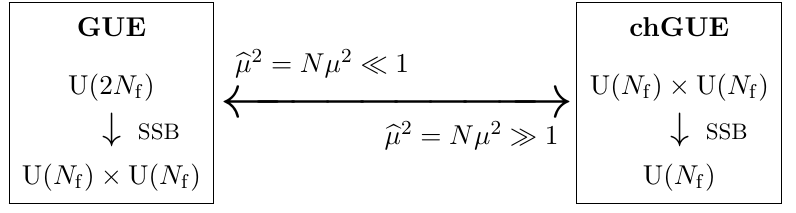
Figure 1 . The large- N crossover in the matrix model (2.3) and its e(cid:11)ective theory (3.6) from GUE to chGUE for varying (cid:22) 2 = N(cid:22) 2 . The patterns of spontaneous symmetry breaking (SSB) in b the massless limit are shown in the two